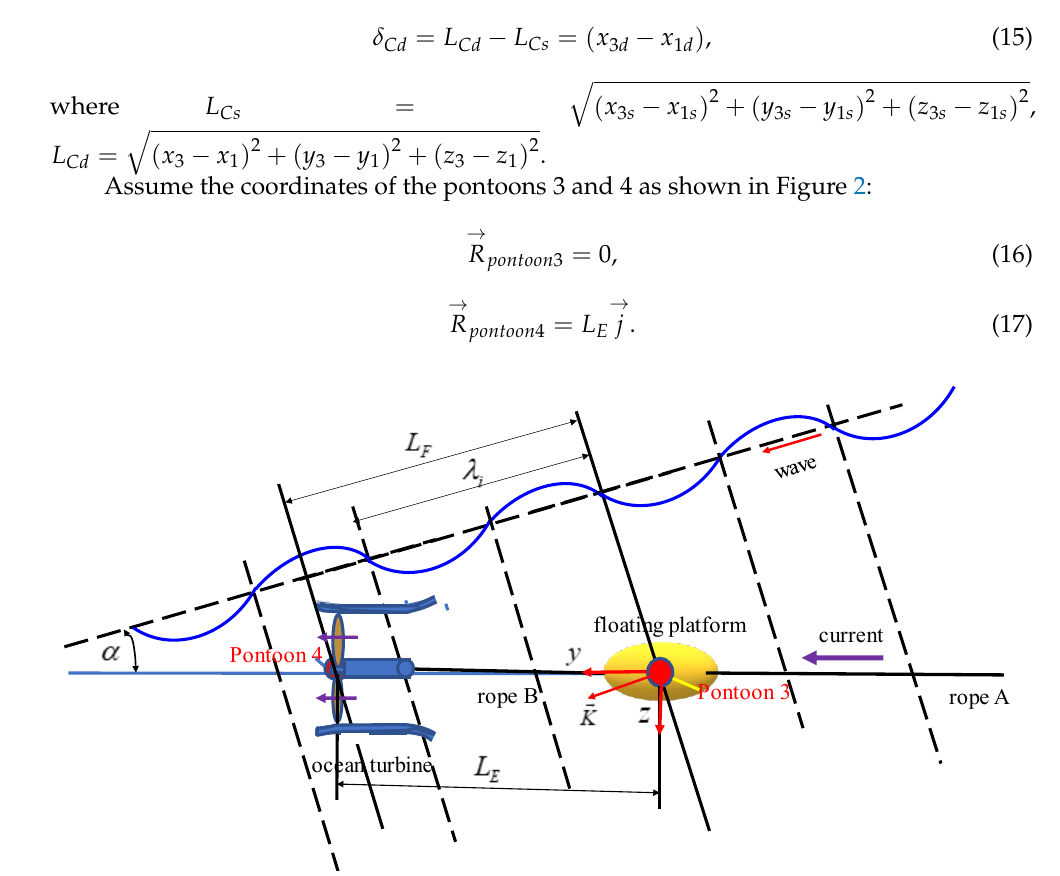
Figure 2. Top view of mooring system under wave and current [5].